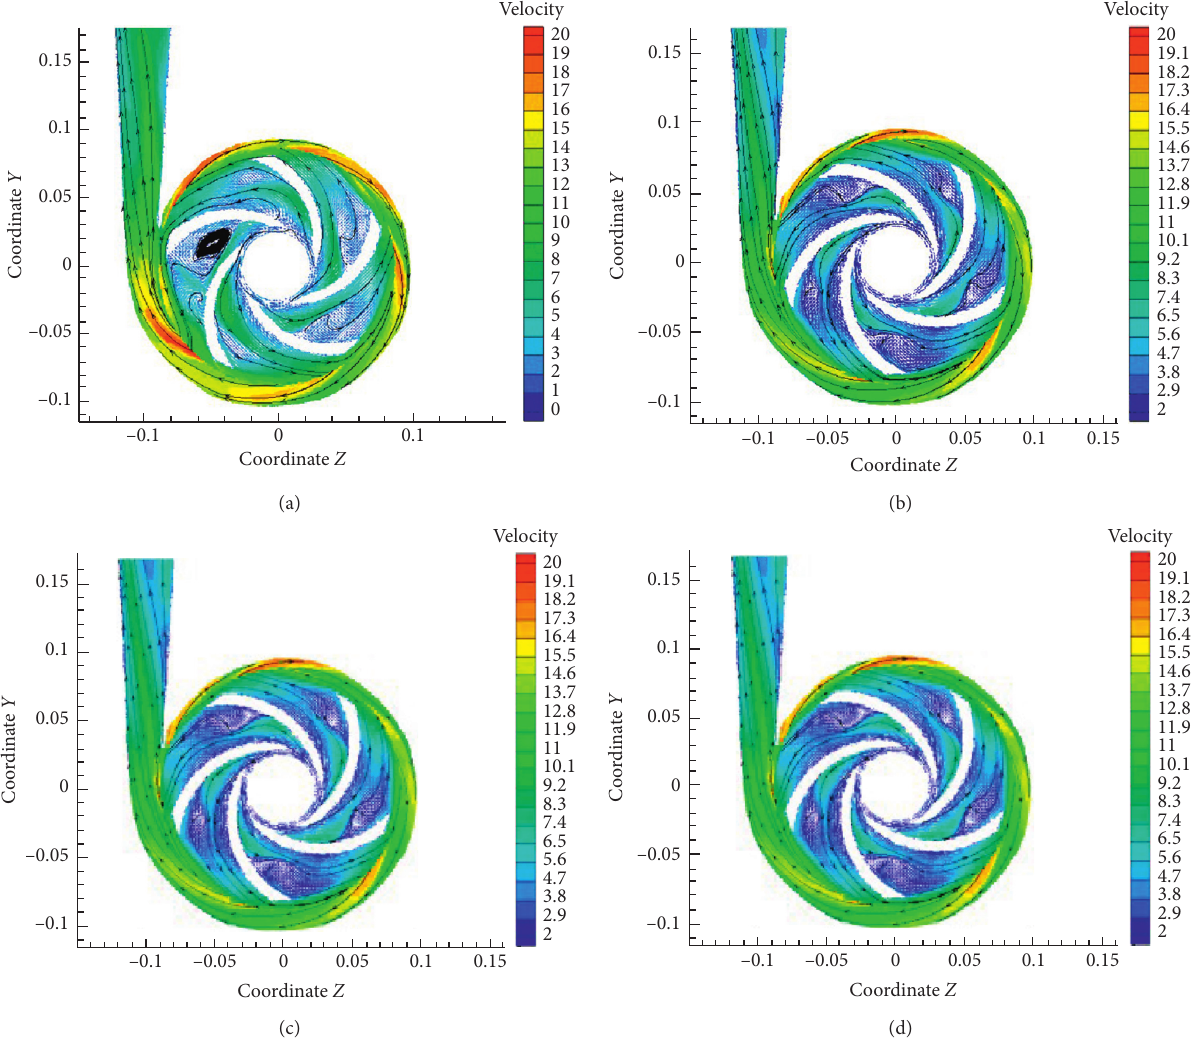
Figure 15: Contours of the velocity of the four impellers. (a) Single arc. (b) Double arc. (c) Logarithmic spiral. (d) B-spline